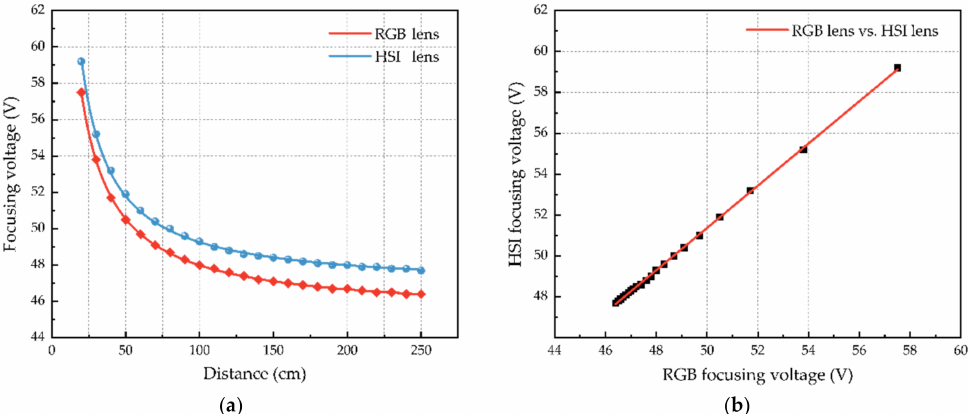
Figure 8. The results of the autofocus calibration: ( a ) the focusing voltage of RGB lens and HSI lens according to the distance at 20 cm to 250 cm; ( b ) the correspondence between focusing voltages of RGB lens and HSI lens in every